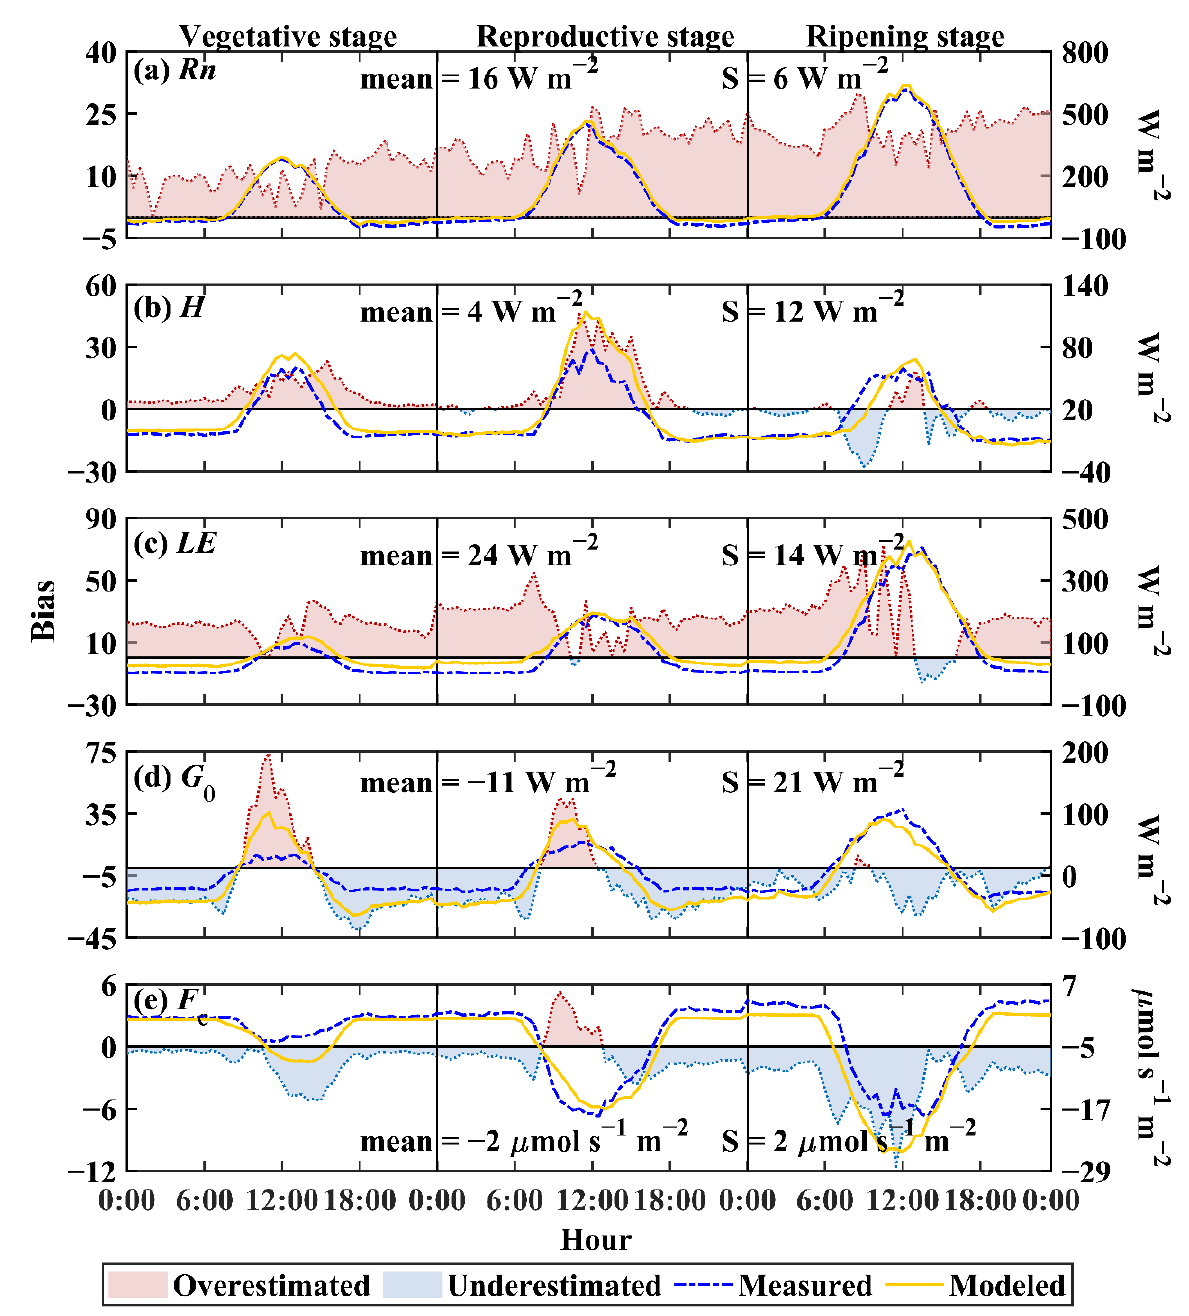
Figure 4. Diurnal variation in ( a ) net radiation ( Rn ), ( b ) sensible heat ( H ), ( c ) latent heat ( LE ), ( d ) surface soil heat ( G 0 ), and ( e ) CO 2 fluxes ( F c ) modeled using SiB2 (yellow lines) against direct measurements (blue lines) in the vegetative, reproductive, and ripening stage. The filters are the biases between the SiB2-modeled and directly measured results (former minus the latter). S is the standard deviation of the biases between the SiB2-modeled and directly-measured results and mean is the mean value of that.